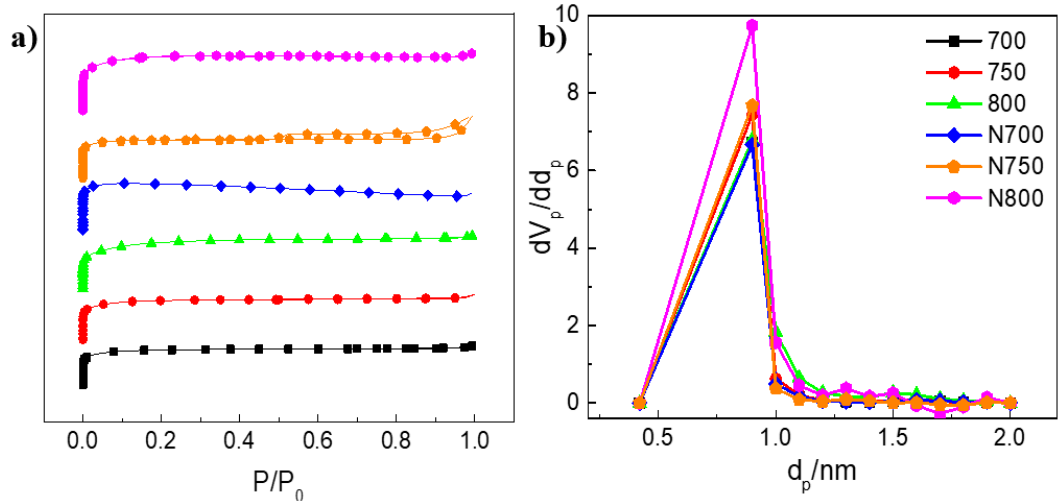
Figure 1. ( a ) Electrocatalysts’ nitrogen adsorption—desorption isotherms and ( b ) micropore size distribution of electrocatalysts based on the micropore (MP) method.